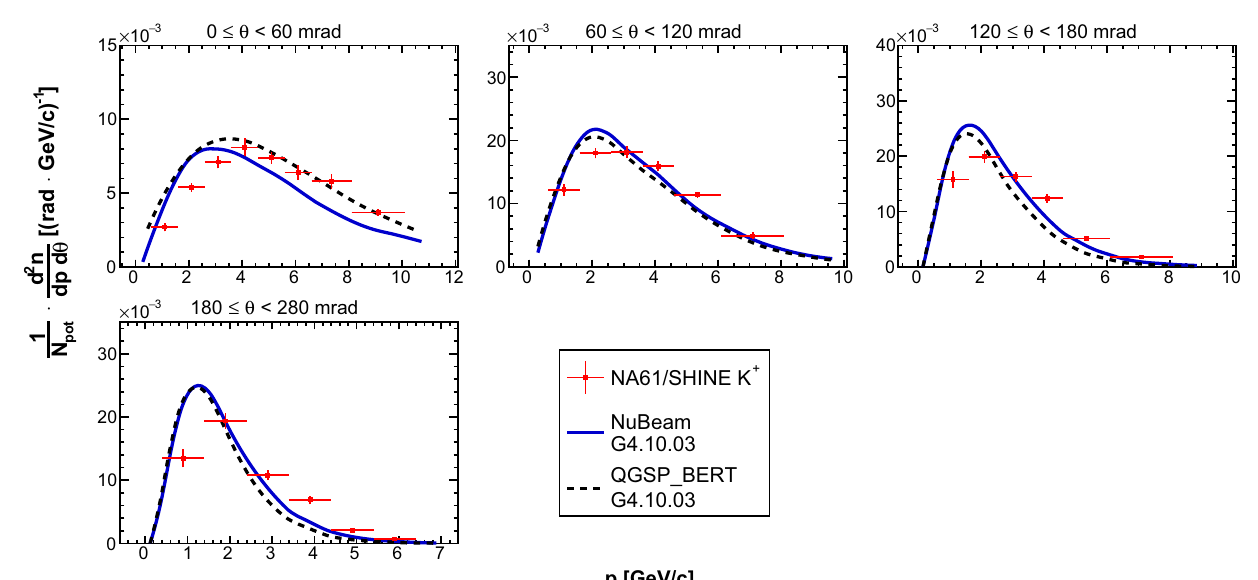
Fig. 38 Double differential yields of positively charged kaons for the fourth upstream longitudinal bin (54 ≤ z < 72 cm). Vertical bars represent the total uncertanties. Predictions from the NuBeam (solid